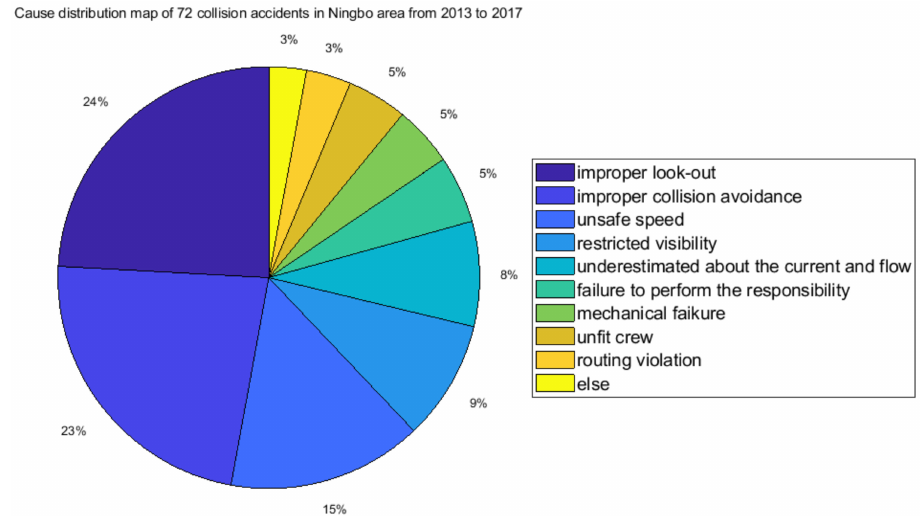
Figure 2. Cause distribution map of 72 collision accidents in the Ningbo area from 2013 to 2017.